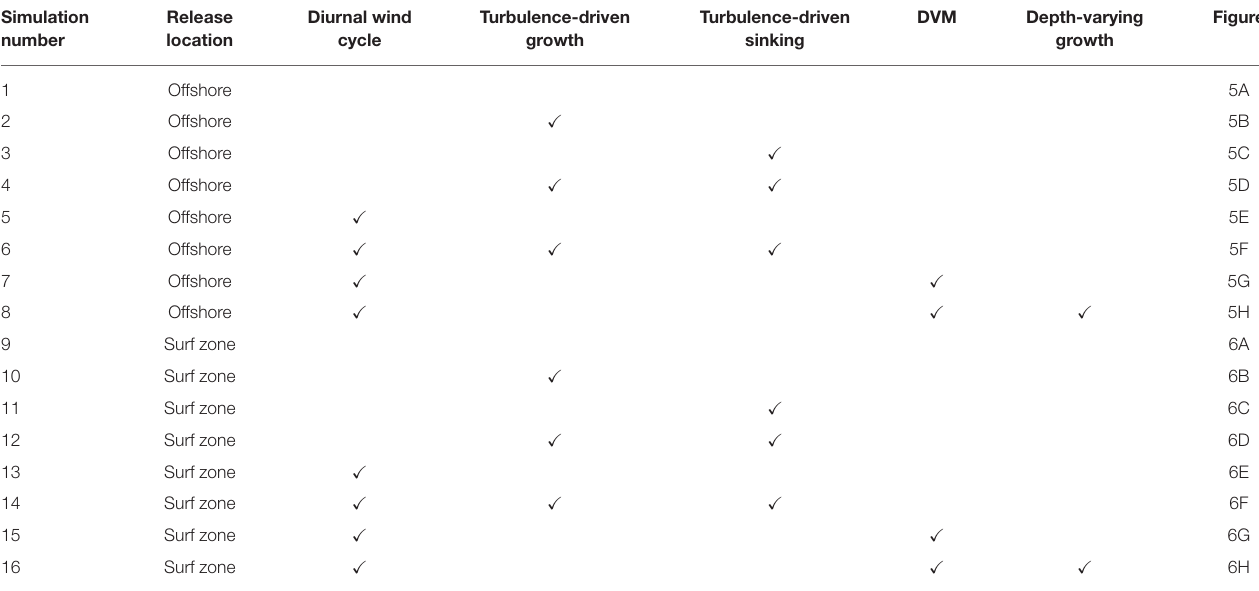
TABLE 1 | Summary of modeled